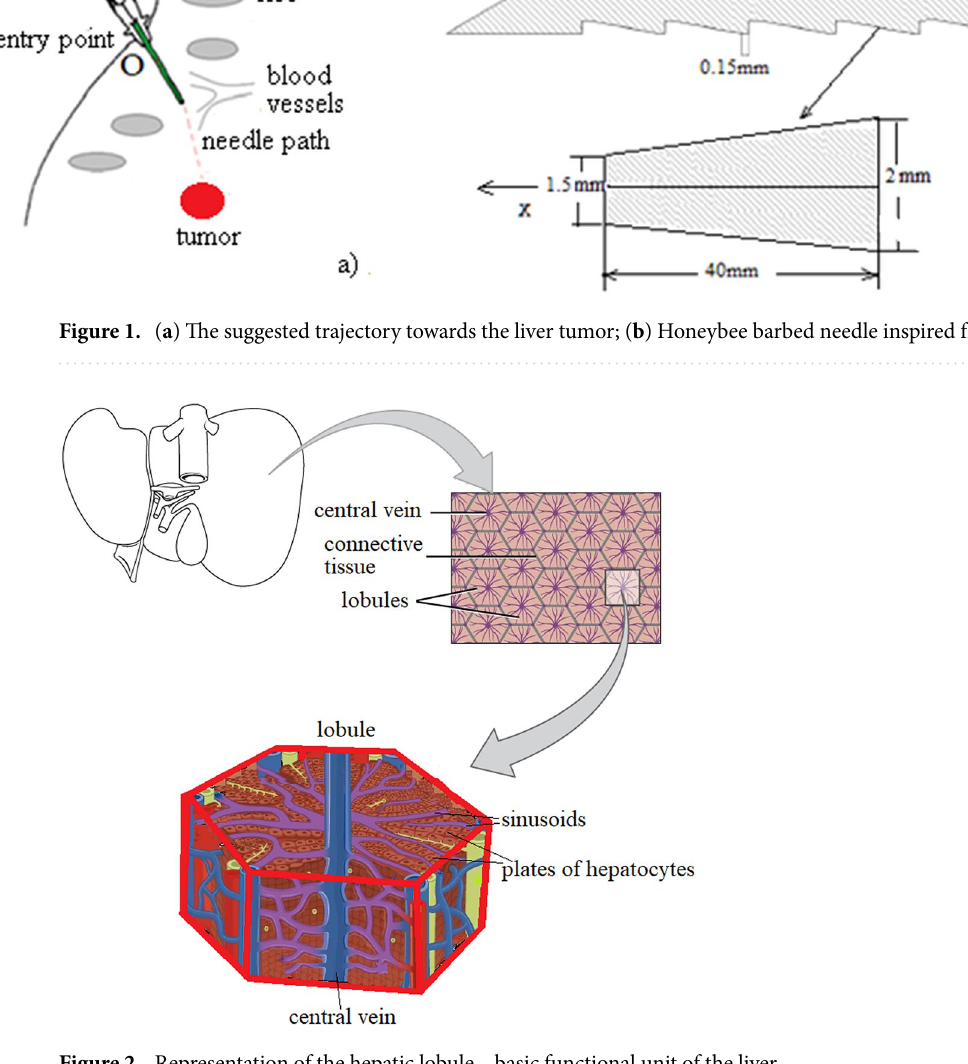
Figure 2. Representation of the hepatic lobule—basic functional unit of the